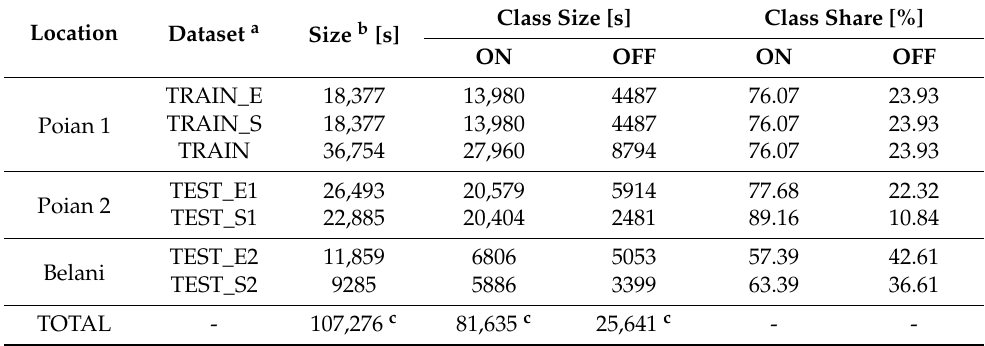
Table 2. Statistics of the used